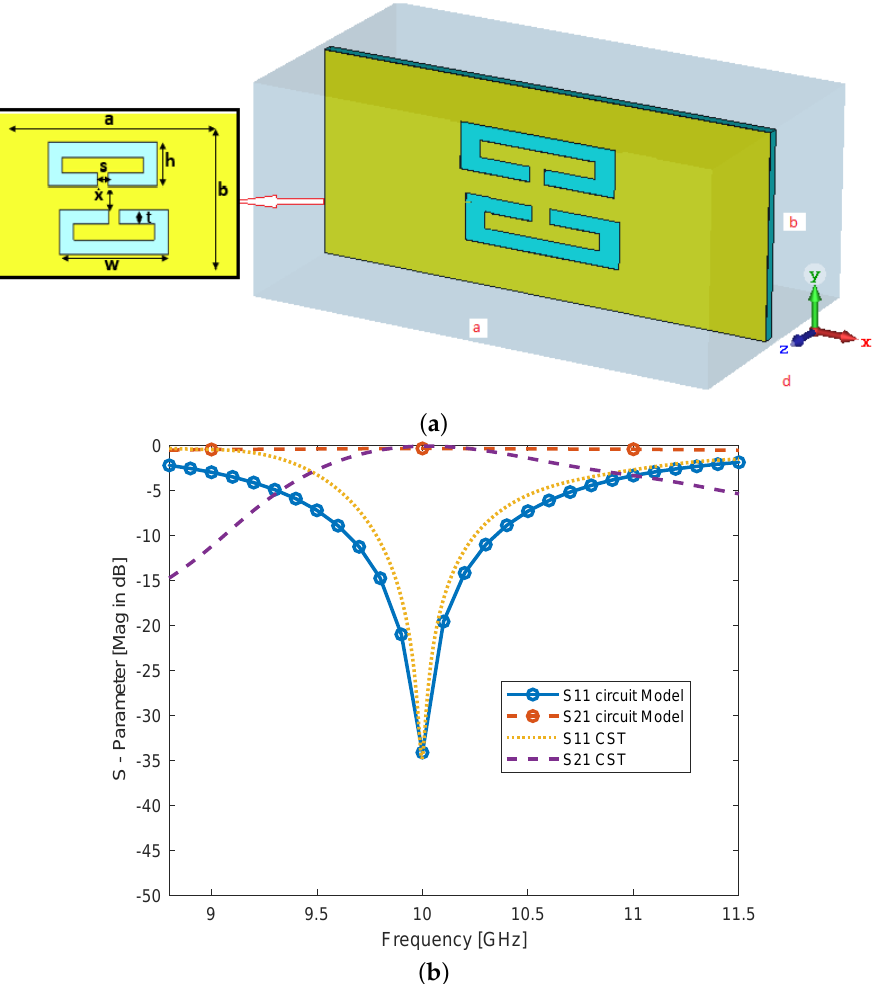
Figure 4. ( a ) rectangular meta-resonator design; ( b ) S-parameter response of waveguide meta-resonator S 11 and S 21 which is compared by using (CST) and a circuit